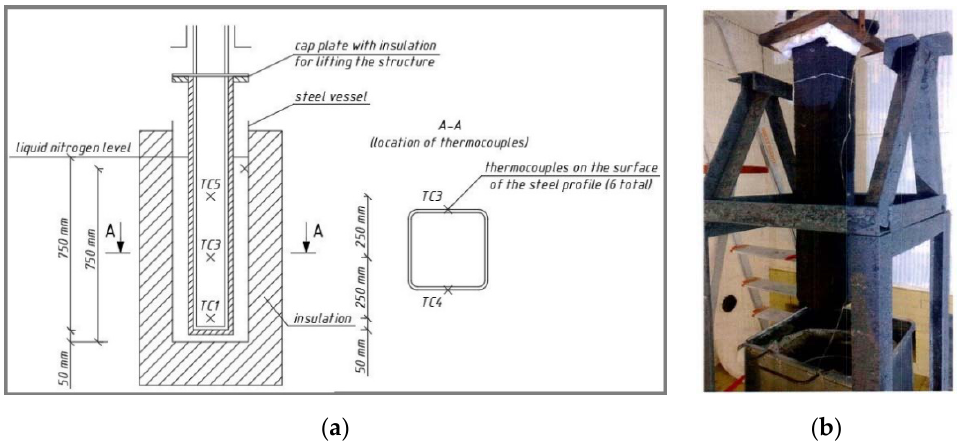
Figure 2. ( a ) Schematic of the test unit for the cryogenic experiment; ( b ) Test unit for the cryogenic experiment.